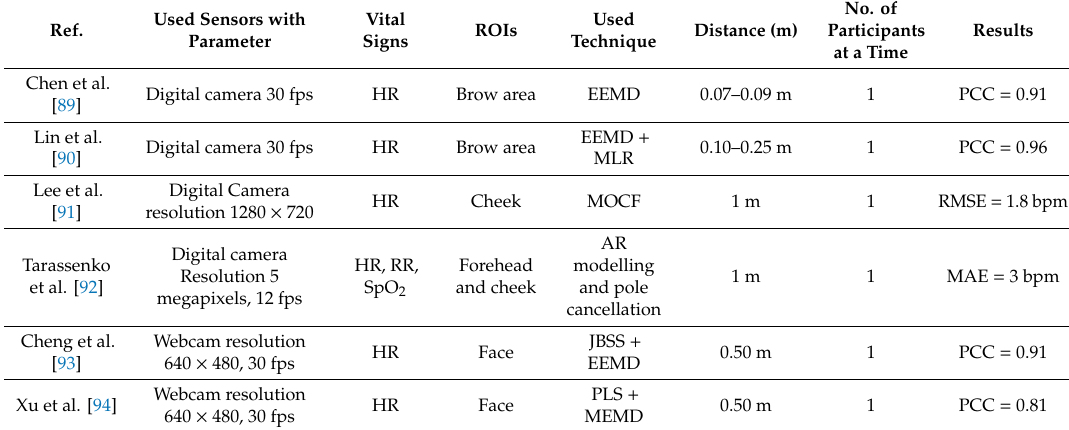
Table 3. iPPG based methods concern about illumination variations.